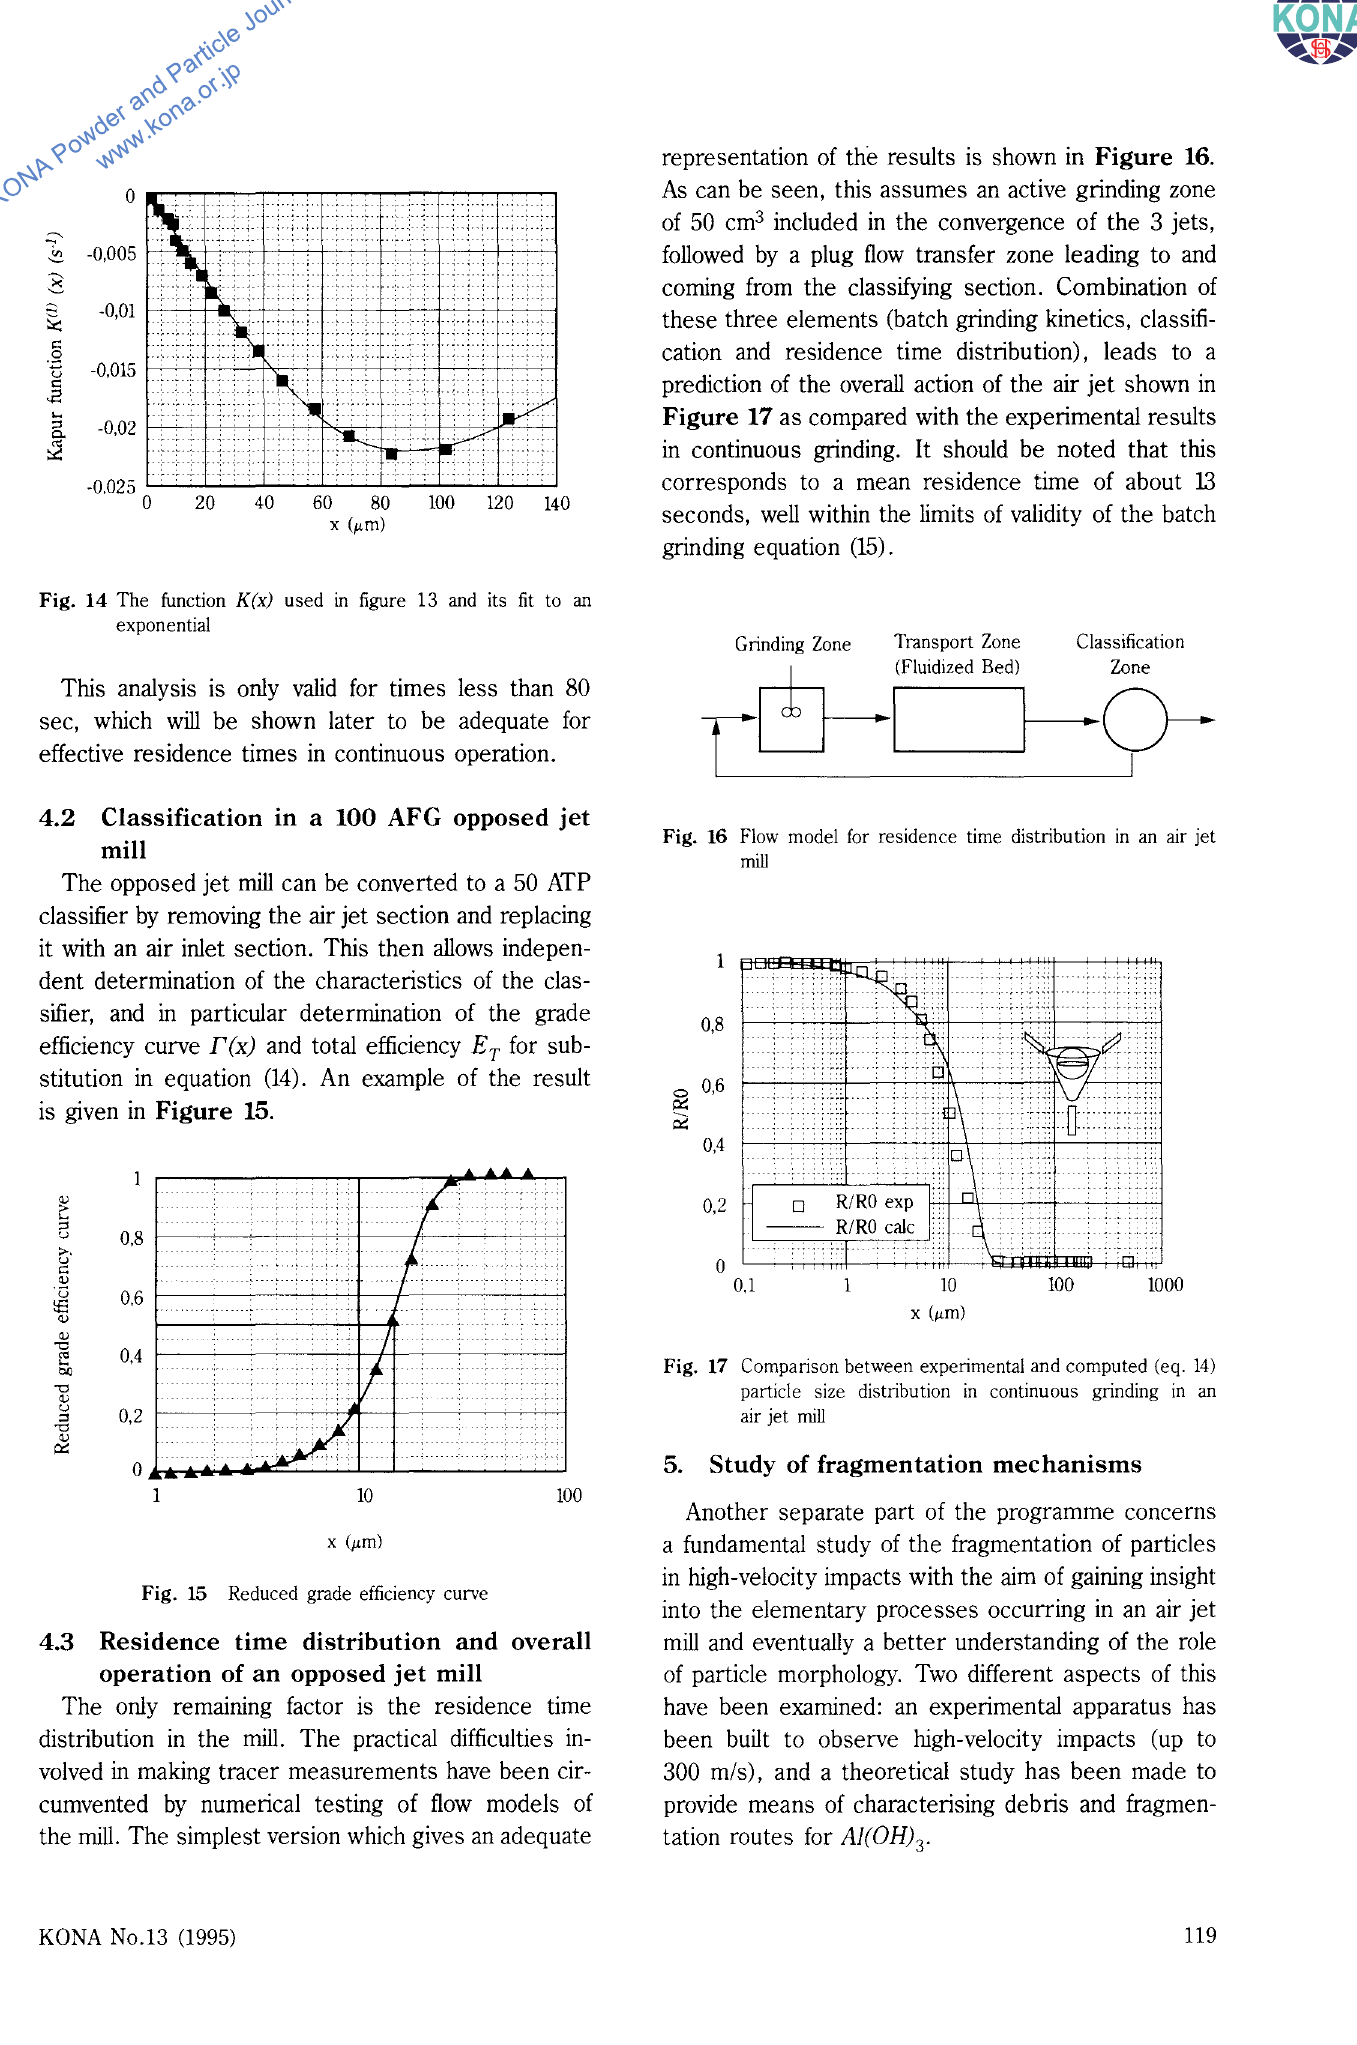
Fig. 15 Reduced grade efficiency curve